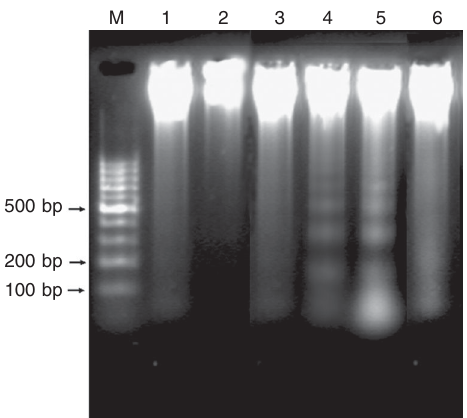
Figure 2. Percentage of apoptotic cells after exposure to different amounts of fraction FA-2- b-ß for different periods of time. The percentage of apoptotic cells was determined by acridine orange staining as described in Material and Methods, with 200 cells being counted for each time. Data are reported as means ± SD and the apoptotic rate of the experimental groups is compared to control. *P < 0.05, **P < 0.01 vs the 0 µg/mL group (Student t -test).